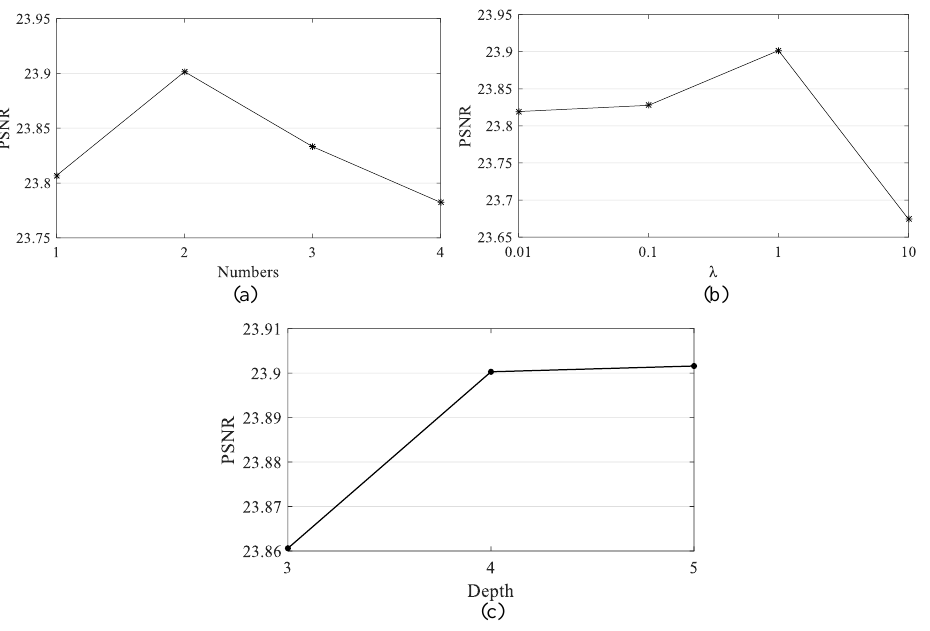
Figure 13. Discuss the effects of parameters ( a ) The effect of convolution times. ( b ) The effect of multi-scale information weight λ . ( c ) The effect of network